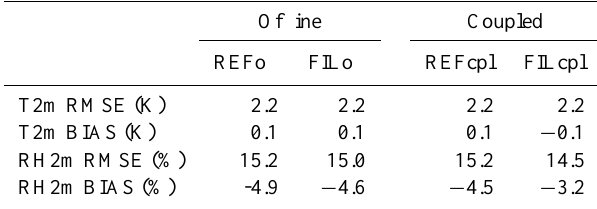
Table 2. Overview of the RMSE and BIAS scores for T 2m and RH 2m averaged over the 13 stations and over July